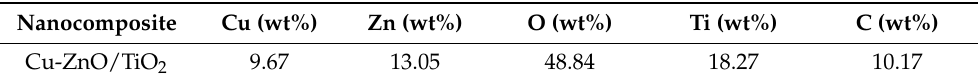
Table 1. Elemental composition of Cu-ZnO/TiO 2 (CZT-2) nanocomposite photocatalyst on weight